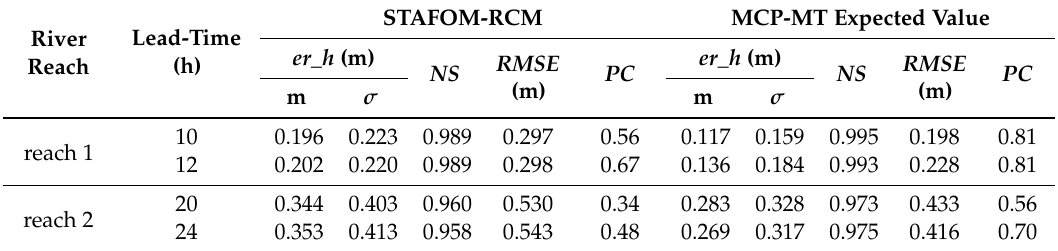
Table 2. Polavaram section (MCP-MT calibrated considering all the available dataset): mean (m) and standard deviation ( σ ) of the absolute error on stage forecast ( er_h ), Nash–Sutcliffe coefficient ( NS ),